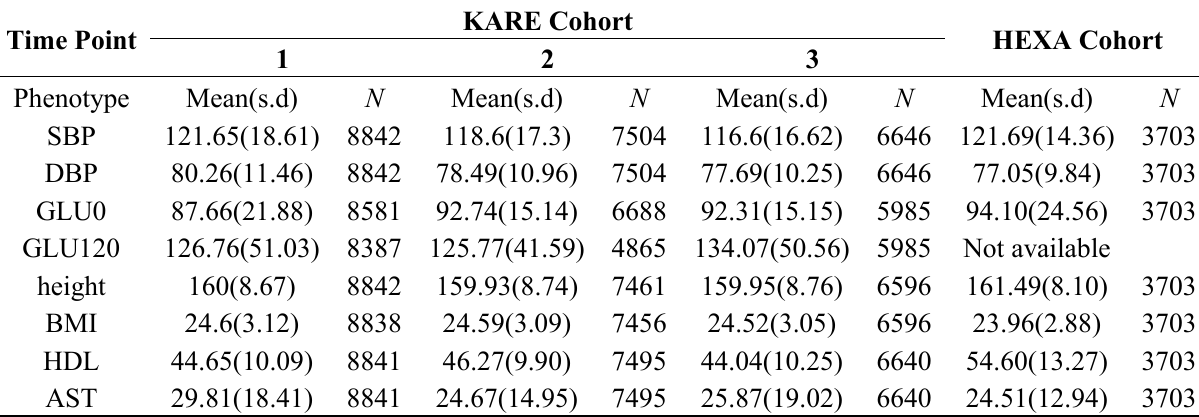
Table 2. Descriptive statistics for eight quantitative phenotypes examined in the Korean Association Resource (KARE) and Health Examinee (HEXA)